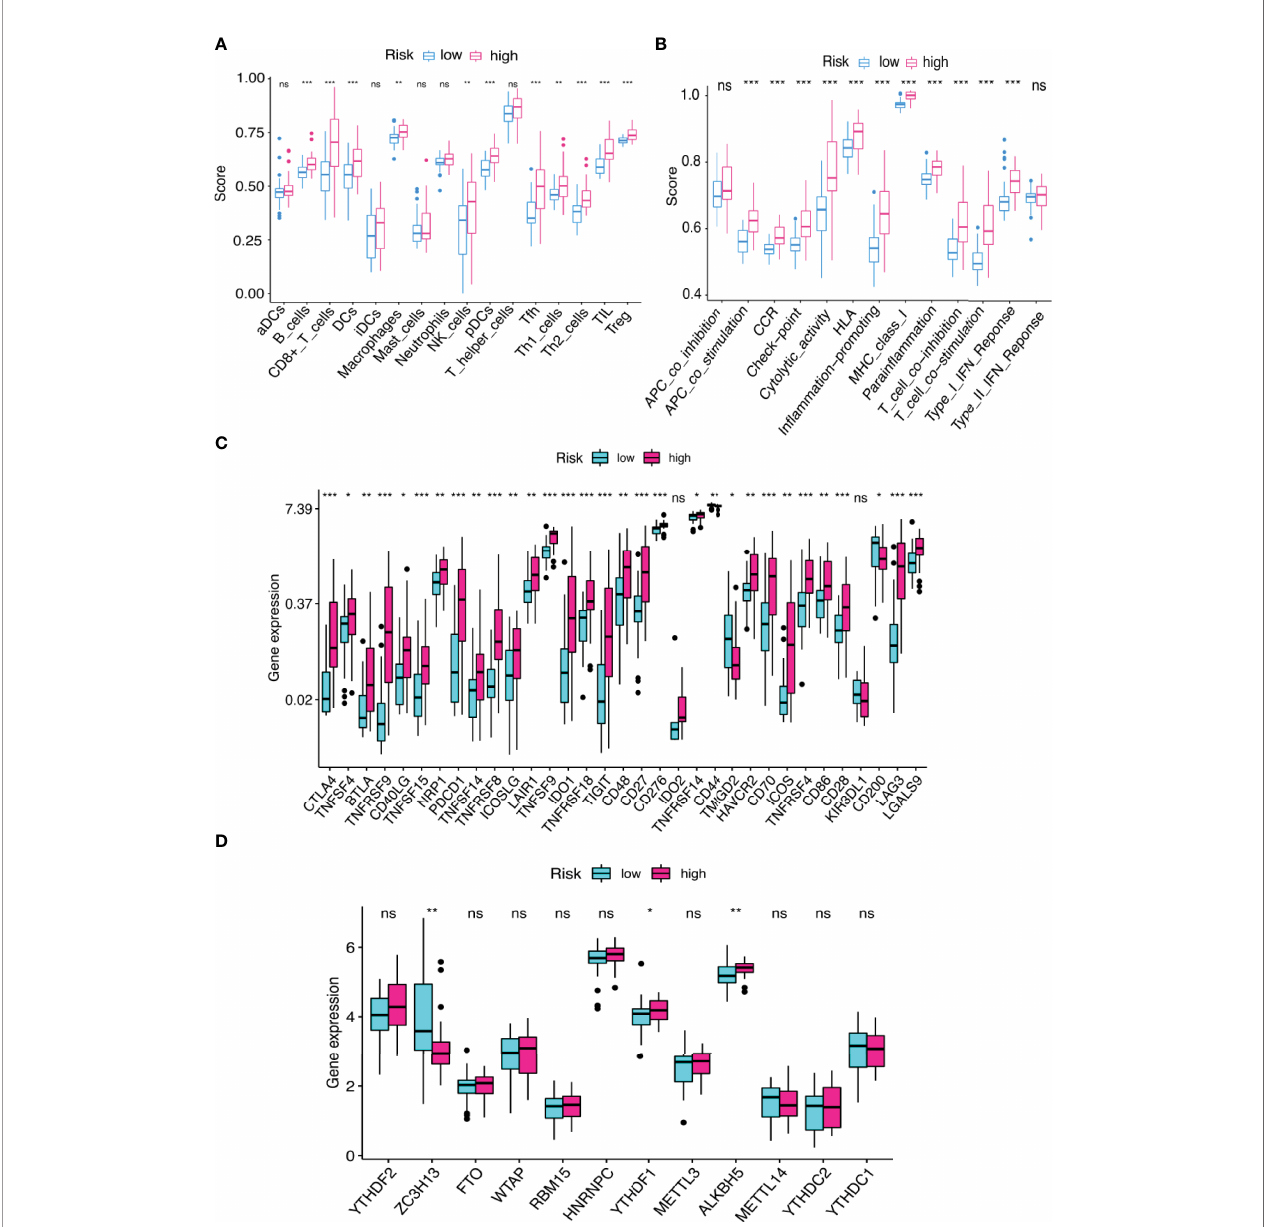
FIGURE 10 | (A, B) The score of (A) immune cell in fi ltration proportions and (B) immune function by ssGSEA. (C, D) The differential gene expression of (C) checkpoints and (D) m6A between two groups. * p < 0.05, ** p < 0.01, and *** p < 0.001. ns, no signi fi